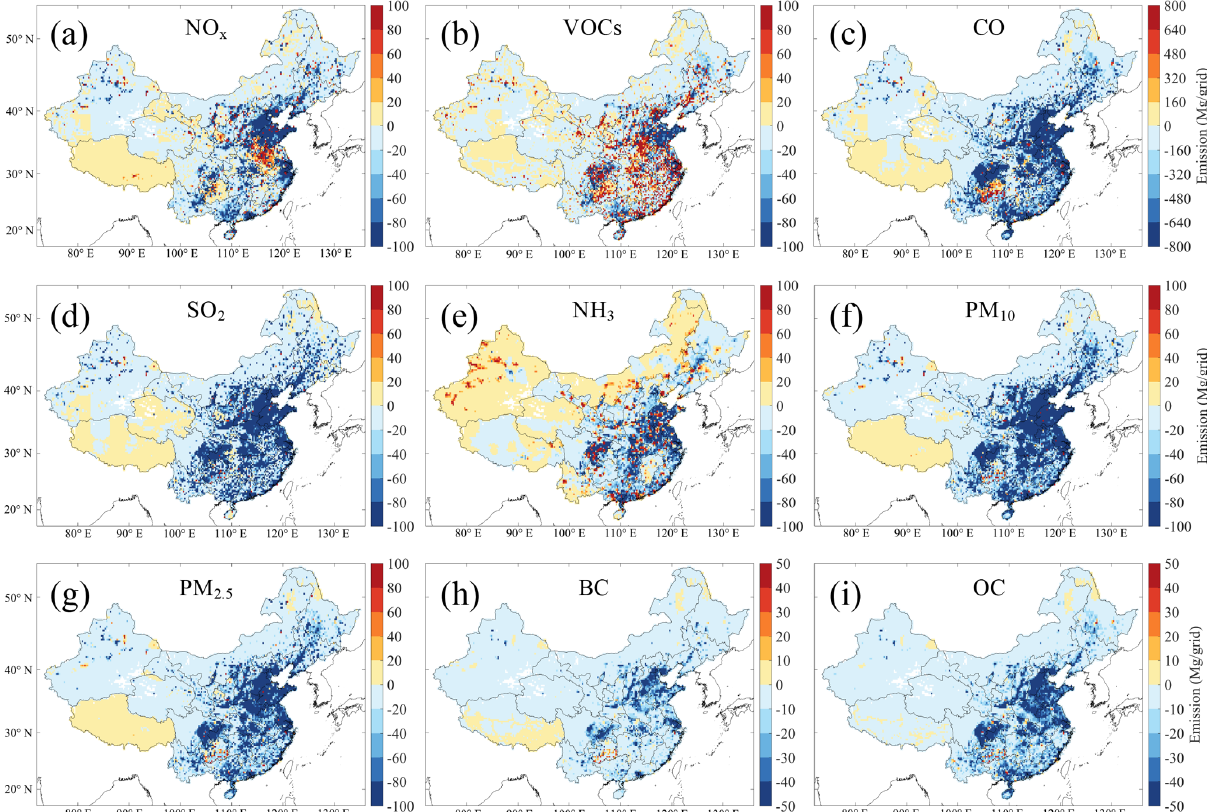
Figure 2. Spatial distributions of changes in anthropogenic pollutant emissions in the summer of 2017 relative to that of 2013, including (a) NO x , (b) VOCs, (c) CO, (d) SO 2 , (e) NH 3 , (f) PM 10 , (g) PM 2 . 5 , (h) BC, and (i) OC. Emission data are obtained from the Multi-resolution Emission Inventory for China (MEIC; http://www.meicmodel.org, last access: 18 January